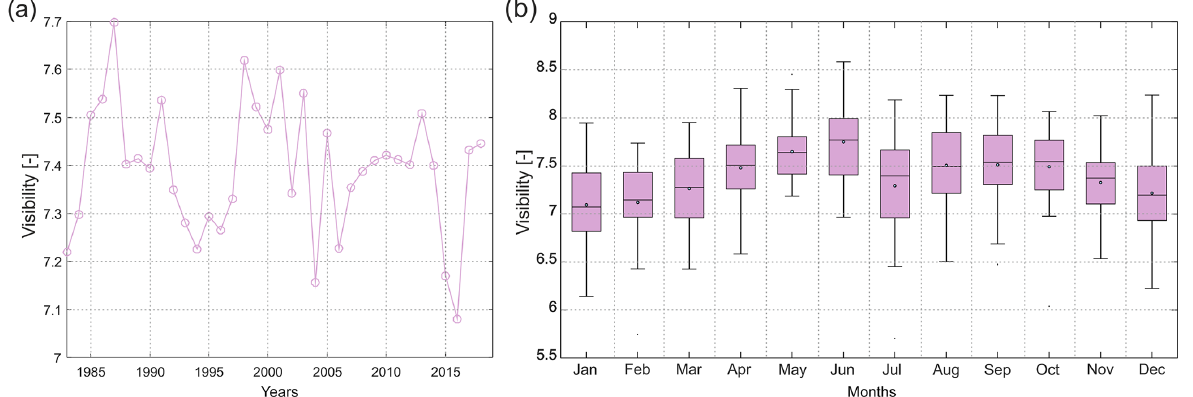
Figure 10. (a) Variability of mean annual visibility in 1983–2018 at Hornsund. (b) Variability of the mean monthly visibility at Hornsund in the period